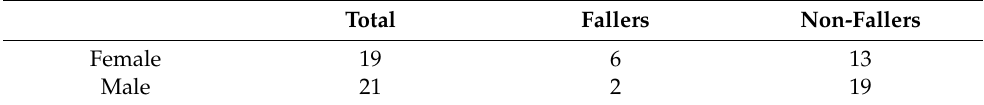
Figure 7. A subject undergoing the SOT test. Table 2. Study group